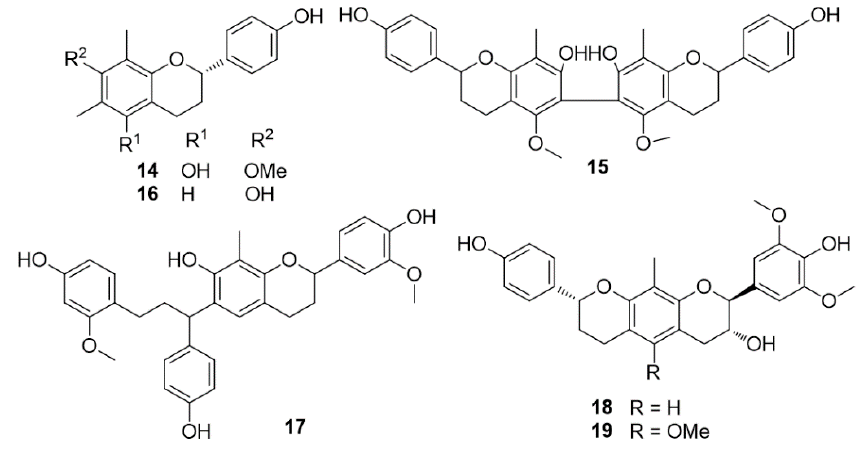
Figure 4. Chemical structures of compounds 14 – 19 isolated from D. cambodiana.